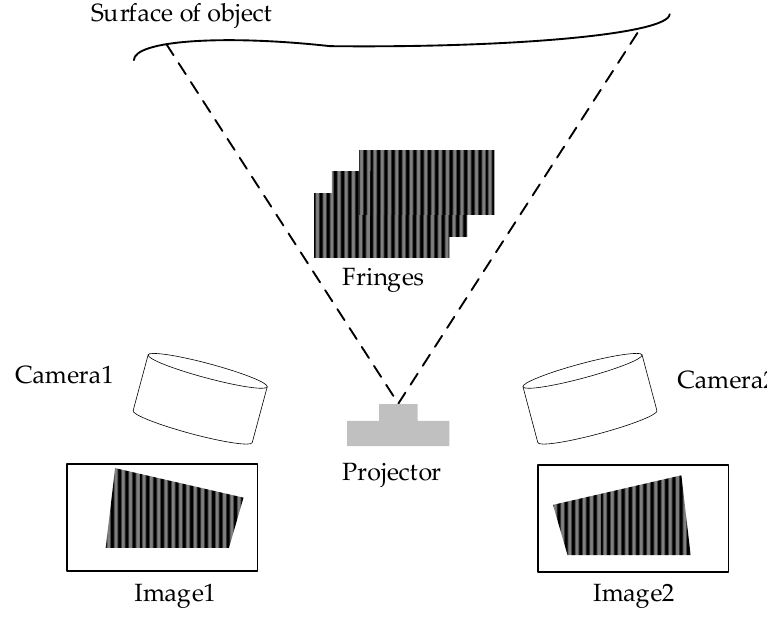
Figure 1. Fringe projection.